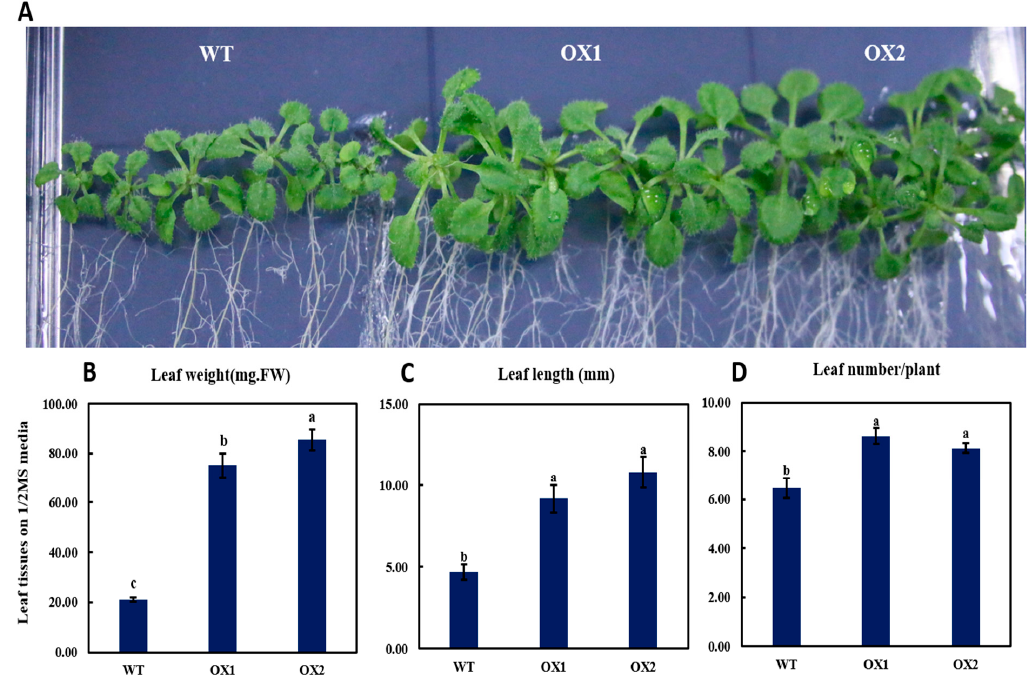
Figure 4. Light-microscopy images of different TEA031065 -over-expression line phenotypes for leaves and their statistical growth-rate capacity in A. thaliana . ( A ) Phenotypes of 21-days old OX-1 and OX-2 versus wild-type leaves; ( B ) leaf fresh weight; ( C ) leaf length; and ( D ) leaf number/plant of control (CK)/wild-type and transgenic (overexpression) lines 1 and 2 gene plants for 21 days. The LSD analysis shown the significant differences among the different treatment by the lowercase letter a > b > c. The values imply means of three biological replicates ± SD. p < 0.05.